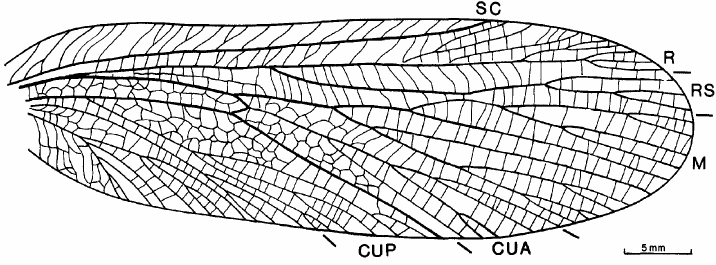
Fig. 18. Gerarus bruesi, drawing of fore wing, based on holotype no. IP